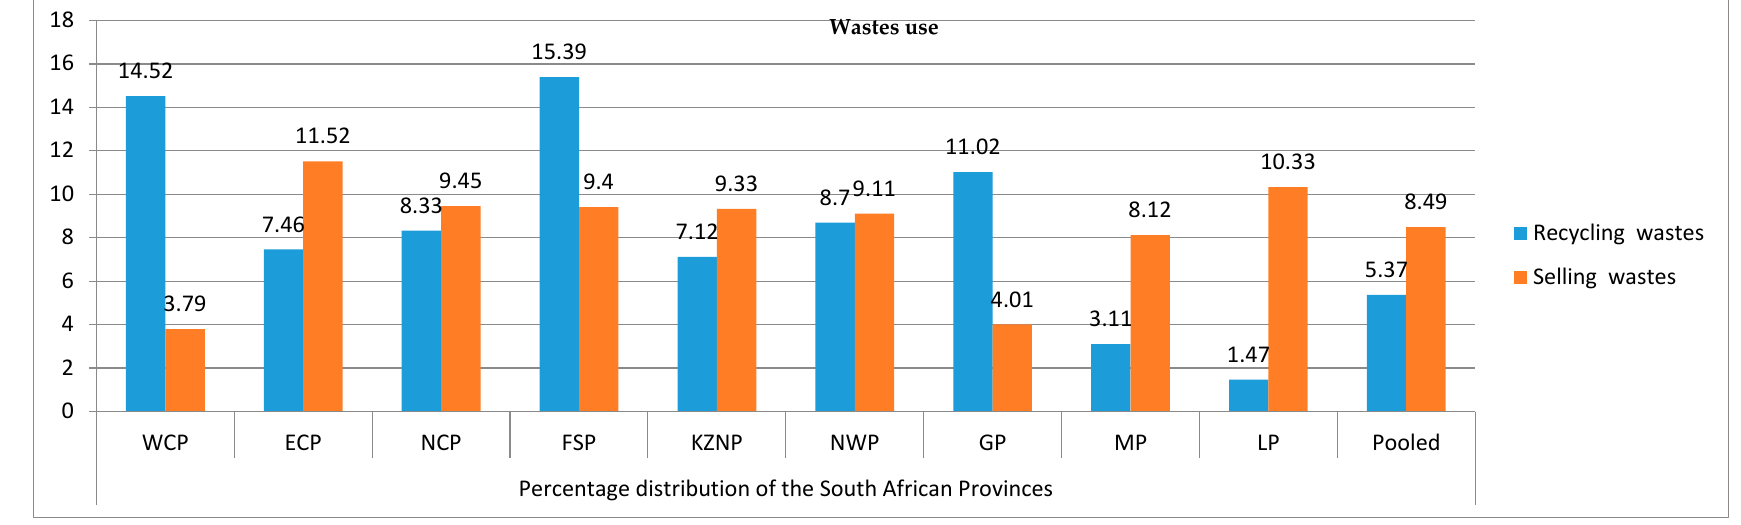
Figure 4. Percentage distribution of households based on recycling or selling waste.